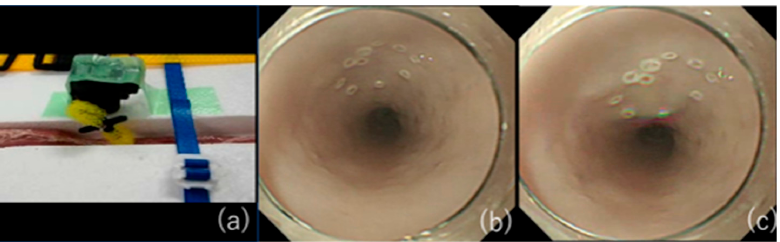
Figure 5. Pulsation is reproduced by the motor devise. ( a ) Pulsation is reproduced when the motor device makes contact with the esophageal wall. ( b ) Noncontact time. ( c ) Contact time. Dynamic pulsation is reproduced.